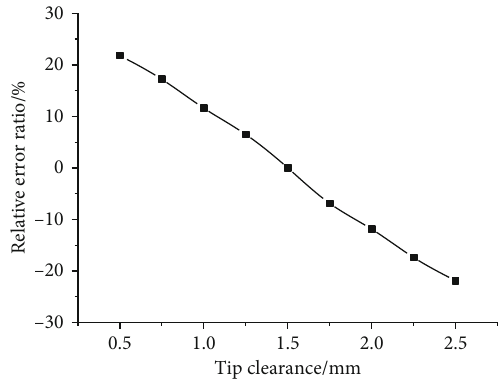
Figure 7: Relative error ratio under di ff erent tip